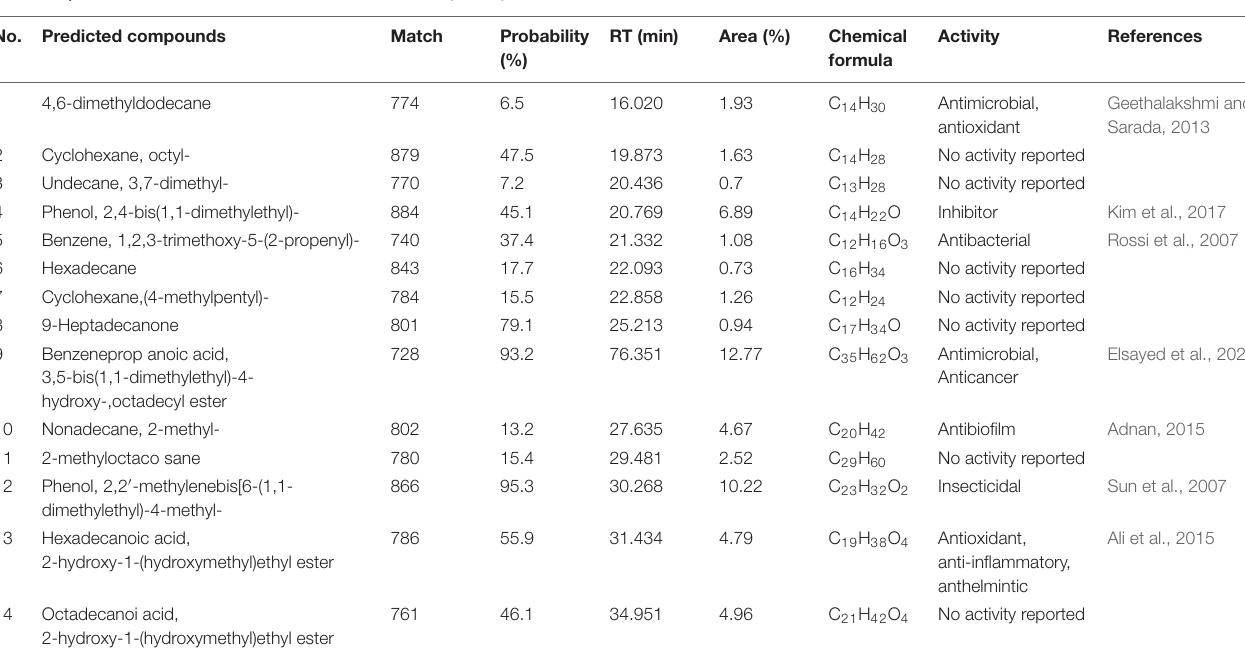
TABLE 1 | Chemical constituents in strain H3-2 extracts analyzed by